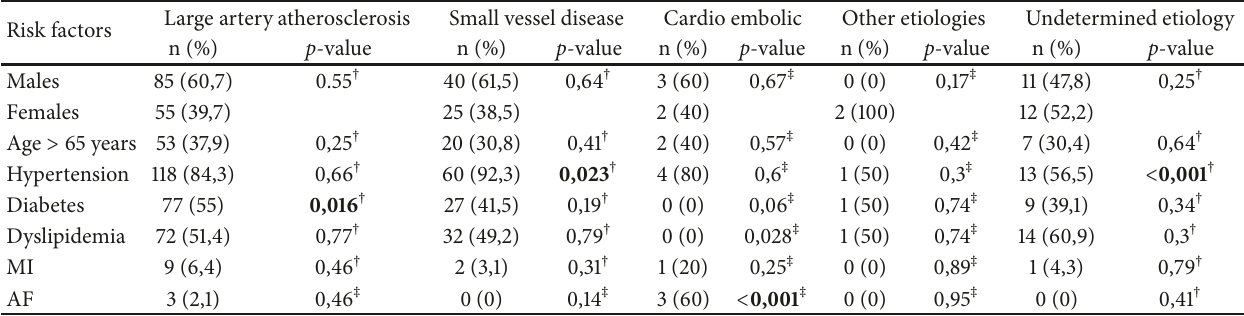
Table 2: Risk factors among ischemic stroke subtypes.